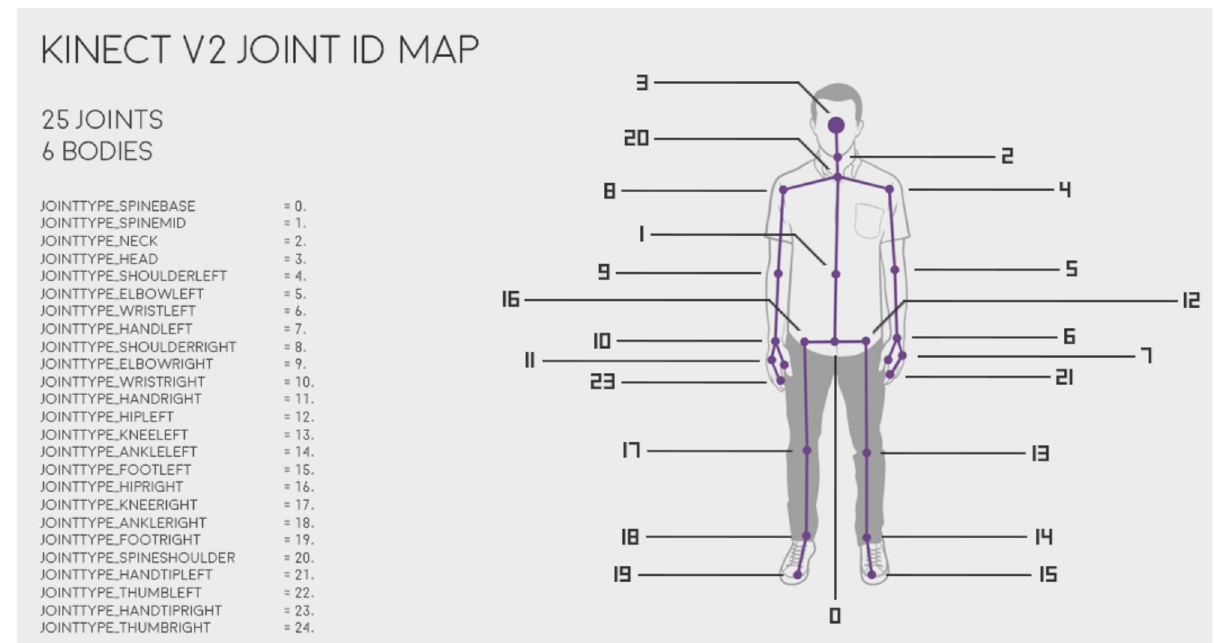
Fig 11. 25 joints detected by Kinect v2 sensor and Kinect body